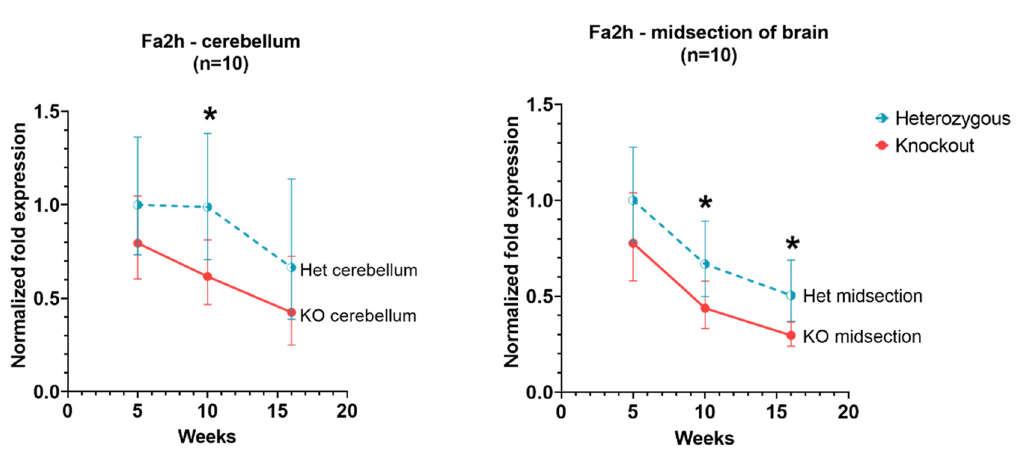
Figure 7. Relative Fa2h expression in the cerebellum and cerebral cortex of Hexb -KO Sandhoff disease mouse model (*— p value < 0.05; midsection of brain represents cerebral cortex).